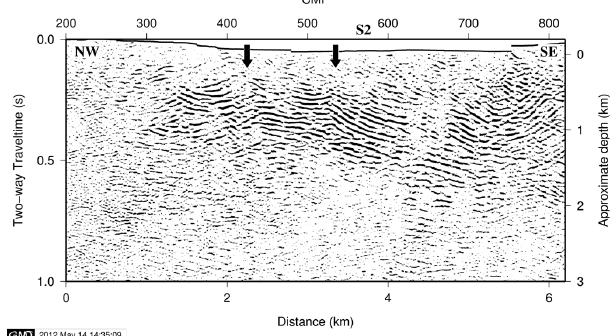
Fig. 3. Final migrated stack of S.P. 1 with marked position of reflec- tion S2 (see also Fig. 8a). Arrows mark sections affected by sharp bends in the recording line (compare with Fig. 2). Elevation marked on top. Length to depth ratio approximately